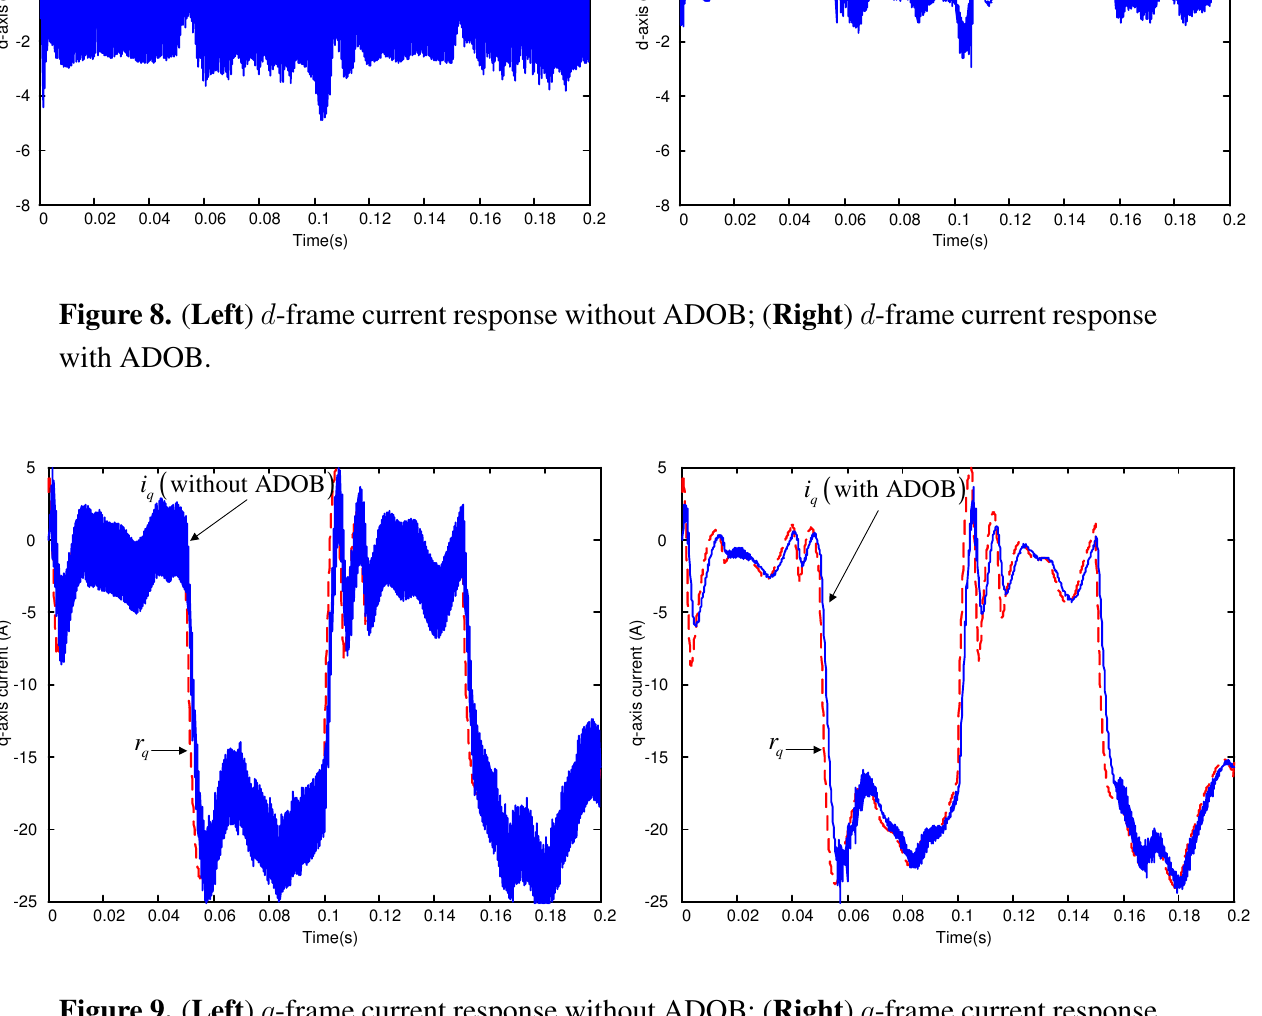
Figure 9. ( Left ) q -frame current response without ADOB; ( Right ) q -frame current response with